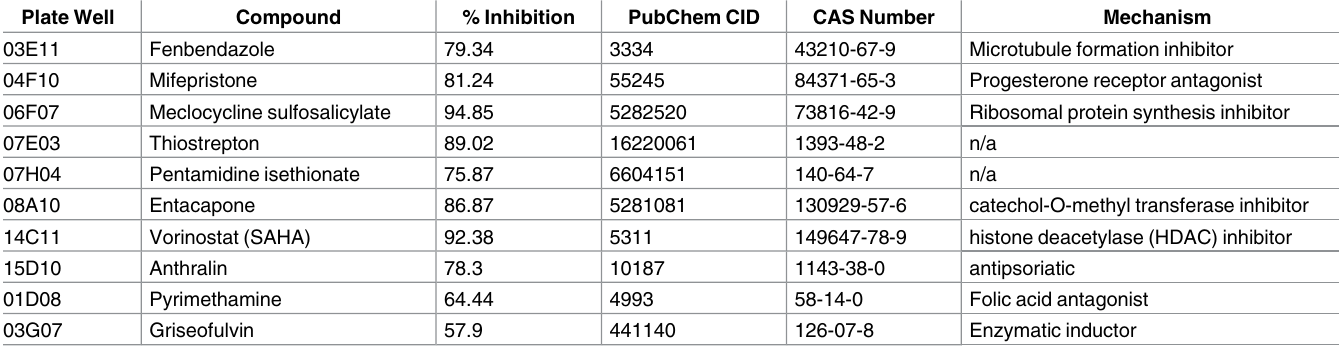
Table 2. The eight highest score and two mid-range score NDST1 suppressors selected for secondary screening. Plate